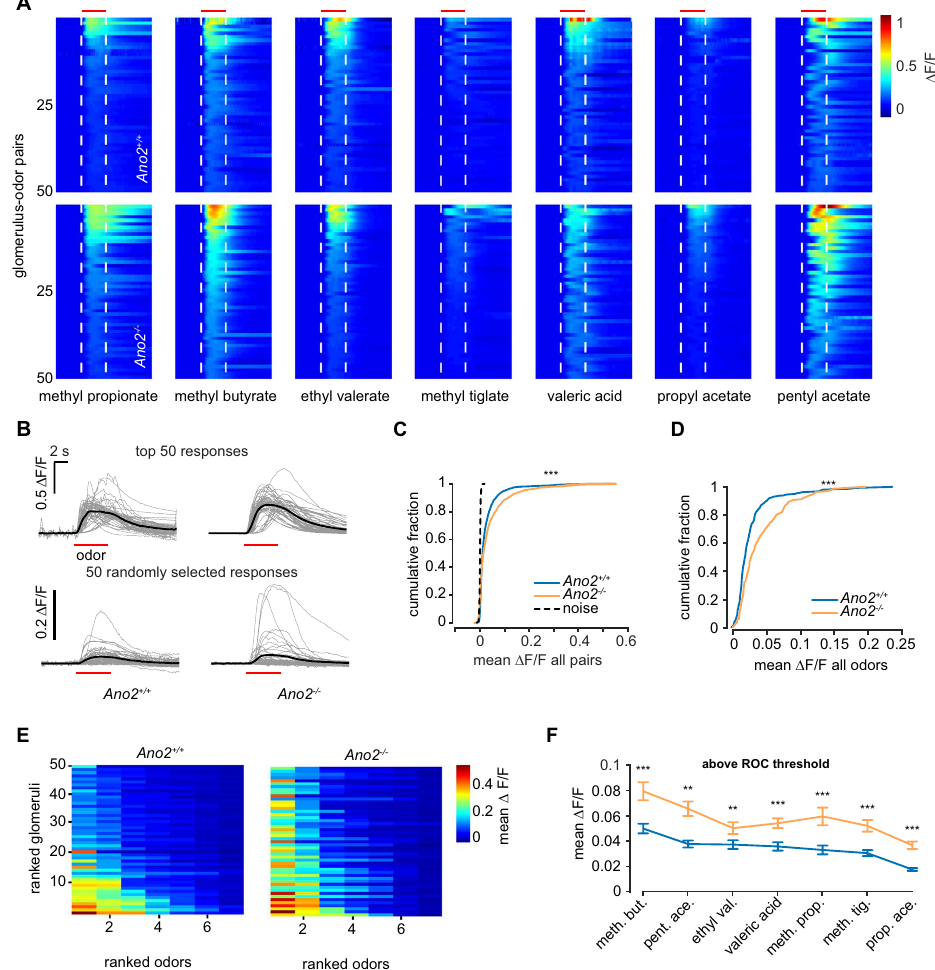
Figure 2. Odor responses in Ano2 − / − and Ano2 + / + mice. (A) The 50 largest odor-evoked Ca 2 + signals across all animals for each of the seven odors in both groups. Dashed lines and red bar indicate odor delivery period. Data are sorted by the largest mean response during odor delivery. ( B) Traces of the 50 largest (top) Ca 2 + responses for Ano2 + / + and Ano2 − / − animals across all odors and 50 randomly selected responses (bottom). ( C) Cumulative distribution of the mean Ca 2 + response in the odor period across all glomerulus-odor pairs (n = 2093 Ano2 + / + and 1526 Ano2 − / − glomerulus-odor pairs, p < 0.001 Kolmogorov–Smirnov test). ( D) Cumulative distribution of the mean Ca 2 + response across all odors at each glomerulus (n = 299 Ano2 + / + glomeruli and 218 Ano2 − / − glomeruli, p < 0.001, Kolmogorov–Smirnov test). ( E) The top 50 glomeruli ranked by mean response across all odors and further ranked by individual odor responses for Ano2 + / + (right) and Ano2 − / − (left) animals. ( F) Mean response of all glomeruli responding above ROC-defined threshold (threshold = 0.005 Δ F/F, Wilcoxon rank- sum test with Bonferroni correction, * p < 0.05, ** p < 0.01, *** p <